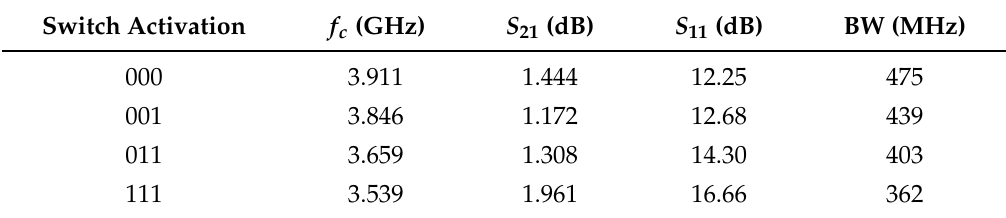
Figure 10. Scattering parameters of the pseudohairpin filter based on PIN diodes: ( a ) return loss S 11 , ( b ) insertion loss S 21 . Table 2. Summary of simulation results of the tunable pseudohairpin filter equipped with PIN diode